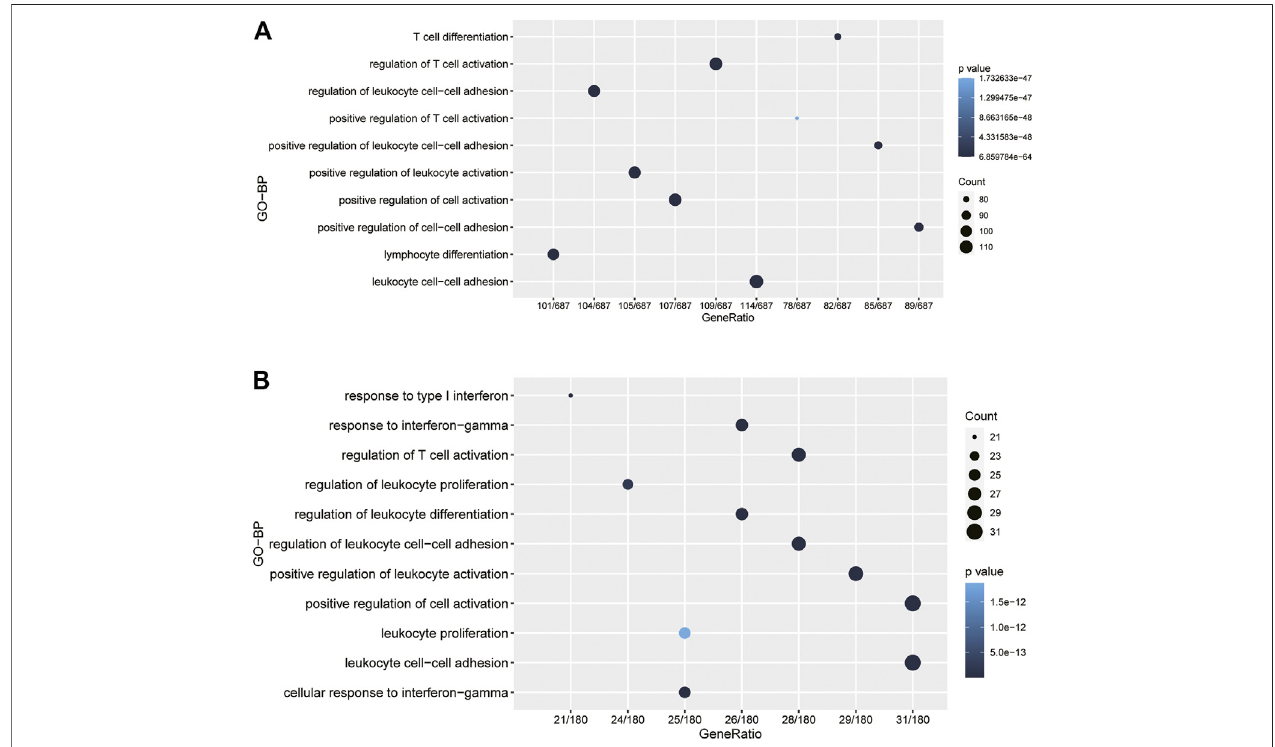
FIGURE 3 | CD80 was closely related to immune functions in breast cancer. Gene ontology analysis showed that CD80 was mainly involved in immune response and in fl ammatory response in the TCGA and METABRIC cohorts (A,B) .